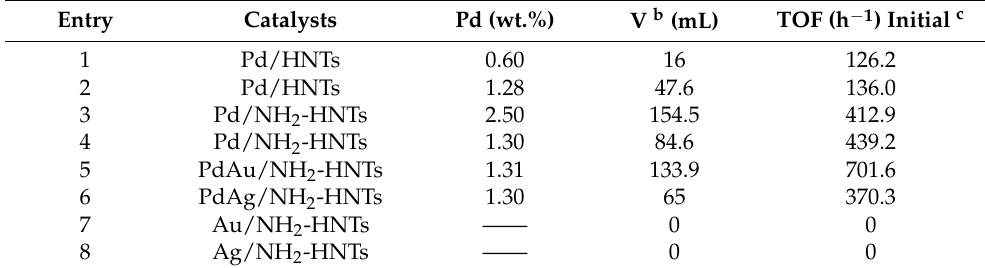
Table 3. Evaluation of catalytic performances of catalysts a .